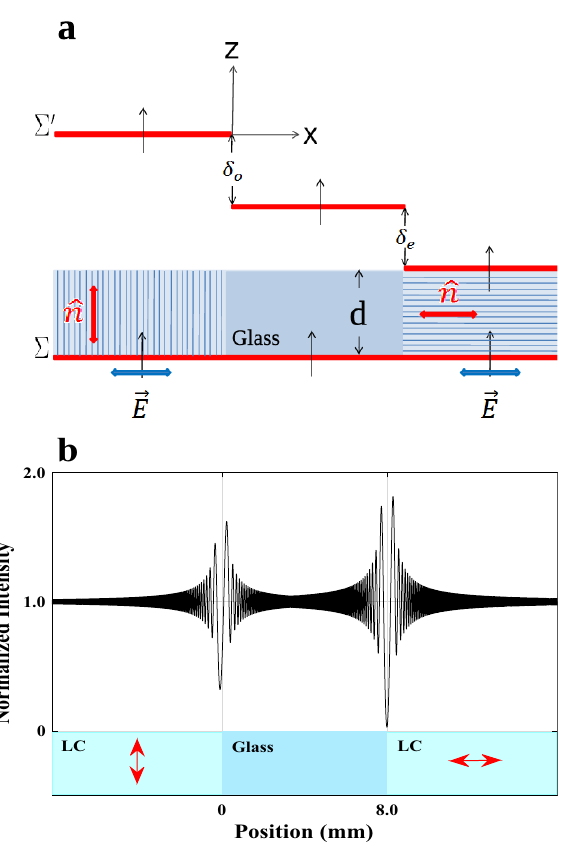
Figure 4. ( a ) The structure of a hypothetical LC cell shows the creation of two phase steps following the passage of a coherent monochromatic plane wave-front, δ o and δ e represent the OPD corresponding ordinary and extraordinary rays, respectively. ( b ) Ordinary and extraordinary LCs that came into contact with the opposing sides of an 8 mm wide glass plate were used to calculate the normalized intensity profiles of the diffracted light from the two phase steps. The average optical axis of the LC is typically denoted by left-to-right